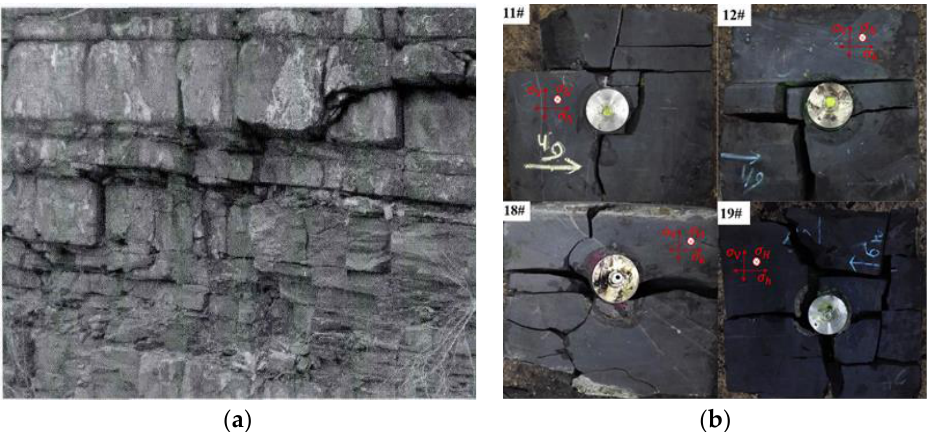
Figure 1. The complex fracture geometry in shale [2]. ( a ) The fracture network in the shale outcrop; ( b ) the secondary fractures in laminated shale.